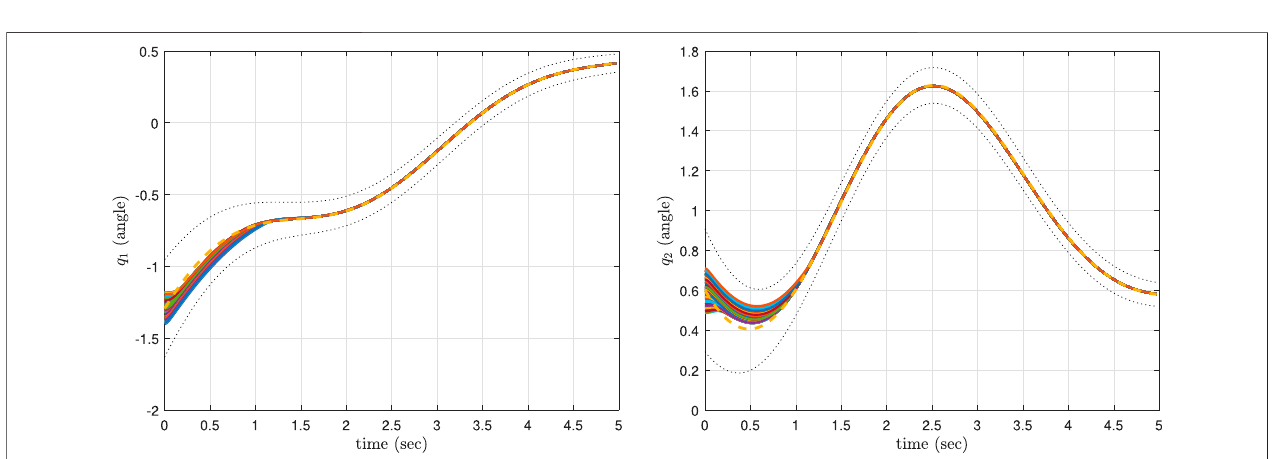
FIGURE 5 | The results of the CLF/CBF-based ProMP controller for the fi rst joint (left) and second joint (right). The safe region of μ i ± σ i , i ∈ {1, 2} is shown as a fi lled “ tube. ” The control results in different trajectories for distinct values of the weight p sci , however all trajectories remain safe. Copyright 2021 IEEE. Reprinted, with permission, from Davoodi et al., 2021.